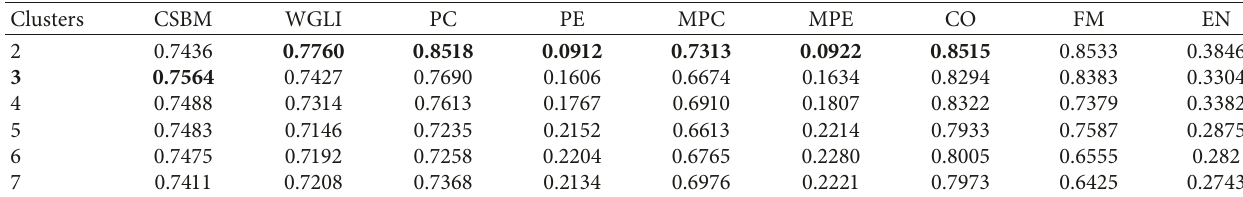
Table 4: Values of each index on the wine dataset.